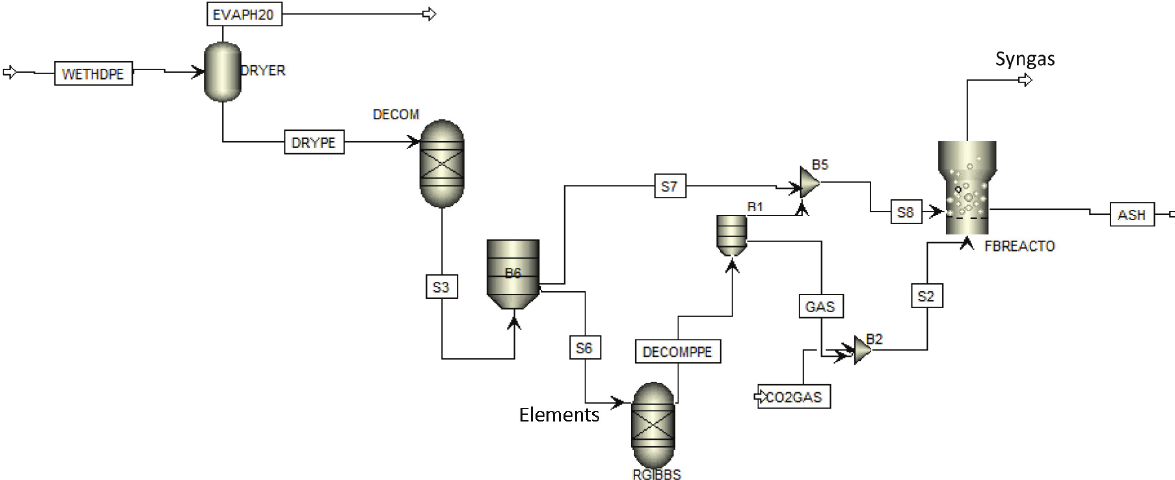
Fig. 1 – Simulation model of the gasification